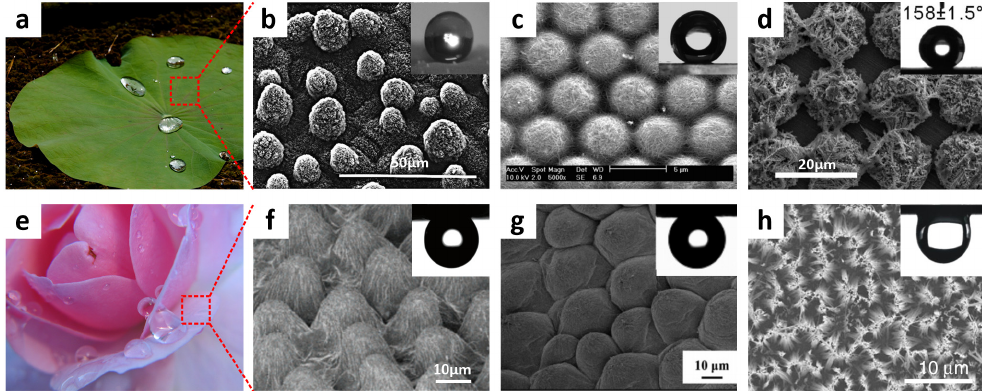
Figure 3. ( a ) Image of a lotus leaf (image by GJ Bulte, reproduced under Creative Commons Attribution Share ‐ alike (CC BY ‐ SA) license); ( b ) the corresponding scanning electron microscopy (SEM) image showing the hierarchical micro/nanostructures comprising papillose cells; ( c ) SEM image of a microsphere/single ‐ walled carbon nanotube (CNT) composite array; ( d ) SEM image of a tetragonal array comprising Cu microprotrusions covered by nanostructured Ag dendrites; ( e ) Photograph of rose petals exhibiting water ‐ adhesive properties; and ( f ) SEM image of rose petal surface (image by Audrey, reproduced under CC BY license); ( g ) SEM image of a rose petal ‐ like polystyrene (PS) ‐ film, onto which